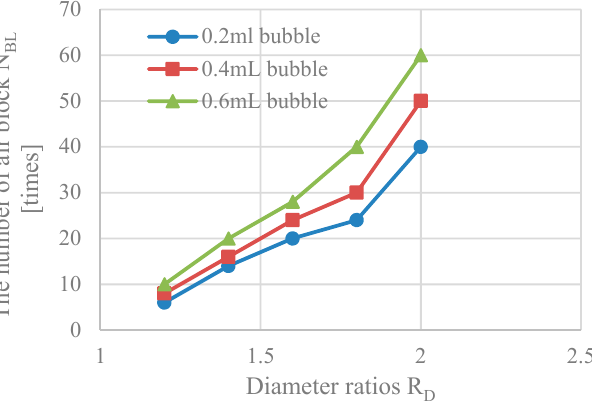
Figure 9. The relationship between diameter ratio R D and air block times N BL , when Thickness of the check valve t = 40 μ m.